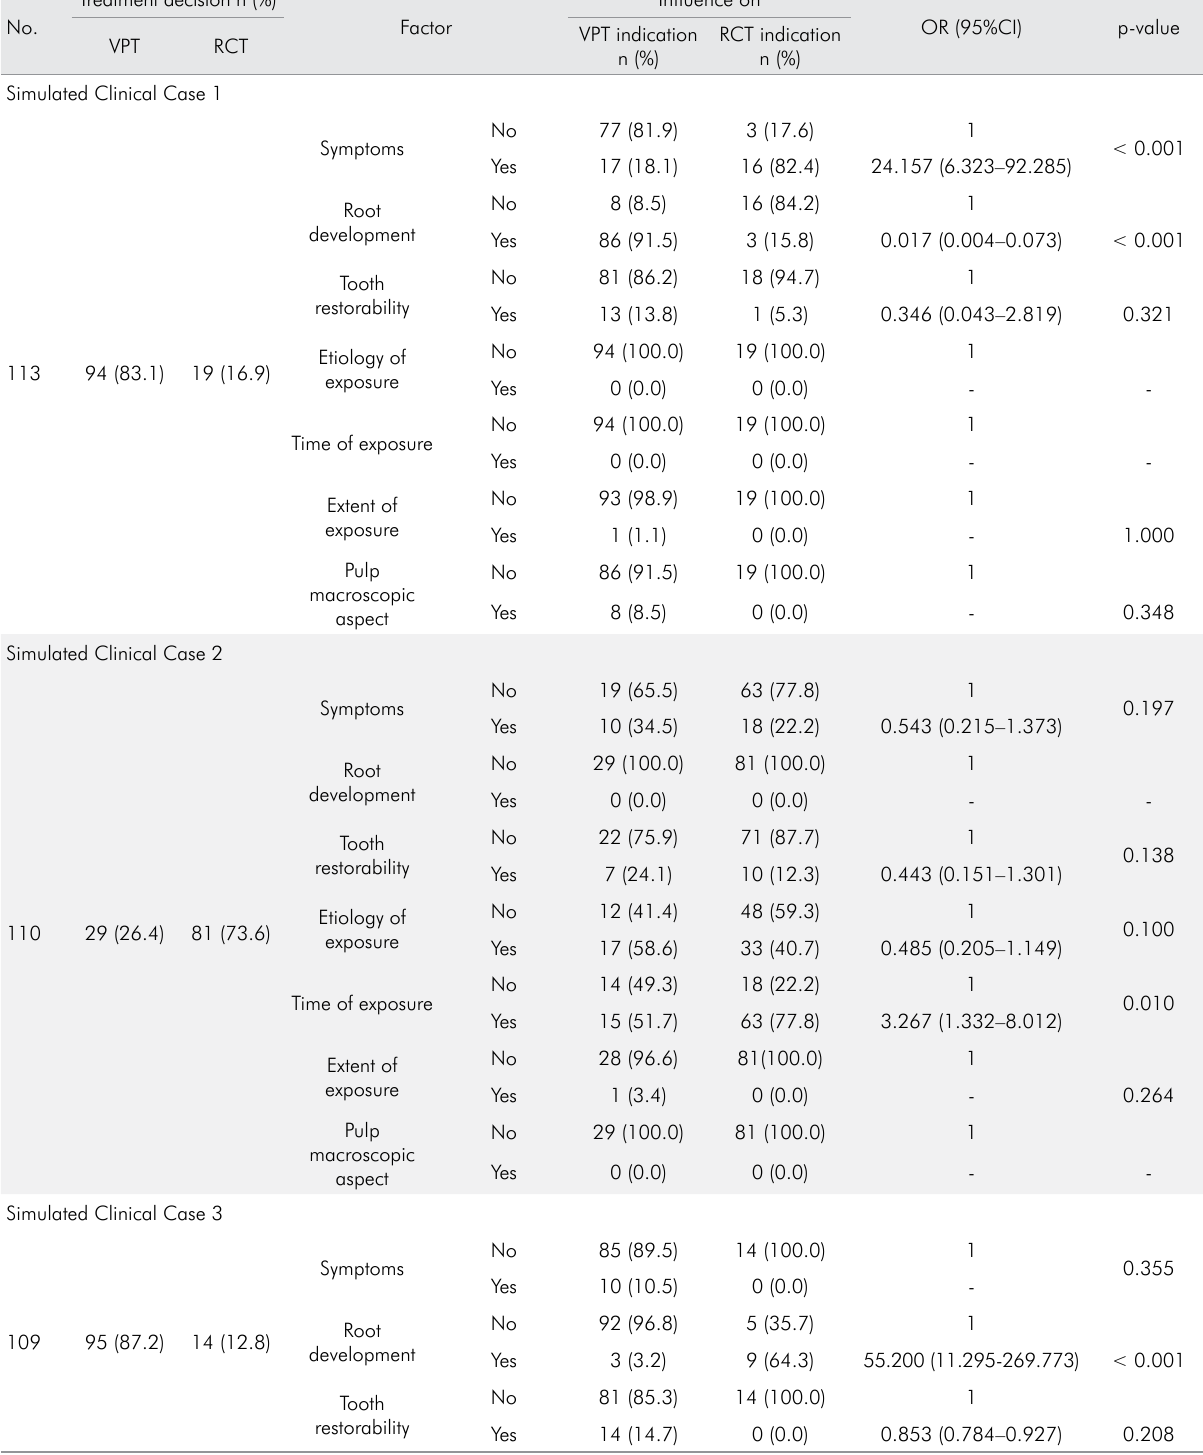
Table 4. Clinical and radiographic characteristics: Bivariate logistic regression model showing significant predictors (p < 0.05), odds ratio (OR), and 95% confidence interval (95%CI) for the preference of root canal treatment (RCT) over vital pulp therapy (VPT). Treatment decision n (%) No.